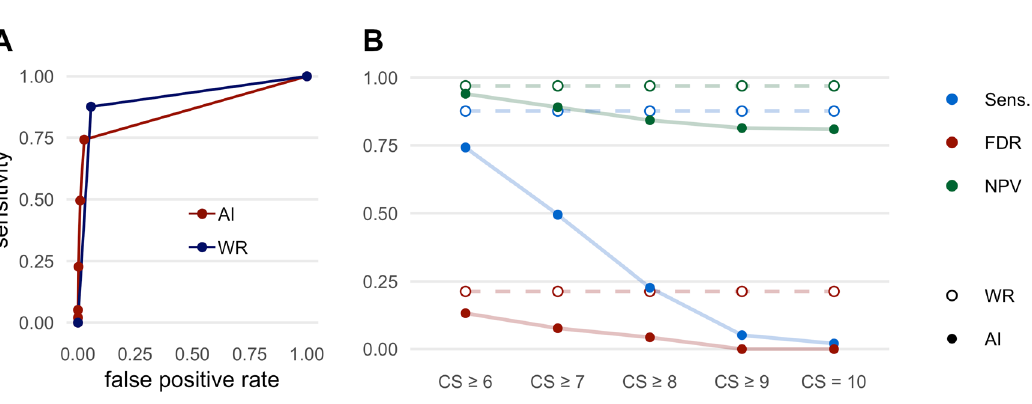
Figure 8. Performance metrics for the detection of pleural effusions. ( A ) Receiver operating characteristic (ROC) curves displaying the performance of the AI Rad Companion Chest X-ray (AI) and the radiologists (WR = written report) for the detection of pleural effusions (area under the curve (AUC) AI = 0.861 / WR = 0.910). ( B ) Sensitivity (Sens.), negative predictive value (NPV) and false discovery rate (FDR) of the AI Rad Companion Chest X-ray (AI) and the radiologists (WR = written report) for the detection of pleural effusions. The sensitivity of the AI is inferior to the sensitivity of the WR at all CS (= confidence scores).